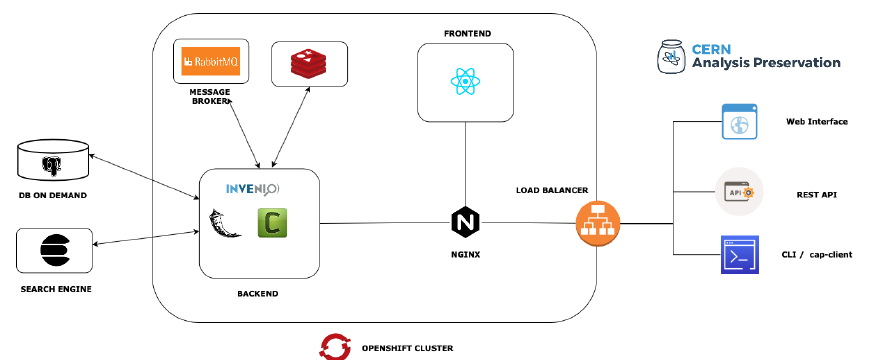
Figure 3: General architecture of CERN Analysis Preservation. The diagram is not exhaus- tive, as CAP interacts and depends on a variety of external APIs and CERN